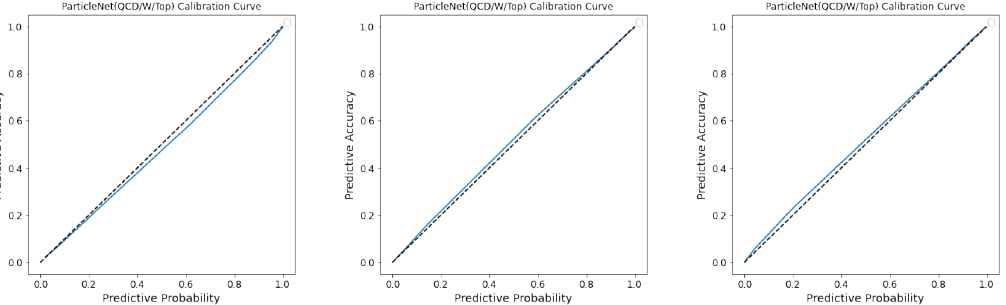
Figure 8 . Calibration curves for ParticleNet trained on QCD/(W, Top) ( left ), W/(QCD, Top) ( middle ), and Top/(QCD, W) ( right